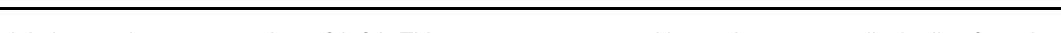
FIGURE 1- Parameters assessed by means of Lateral